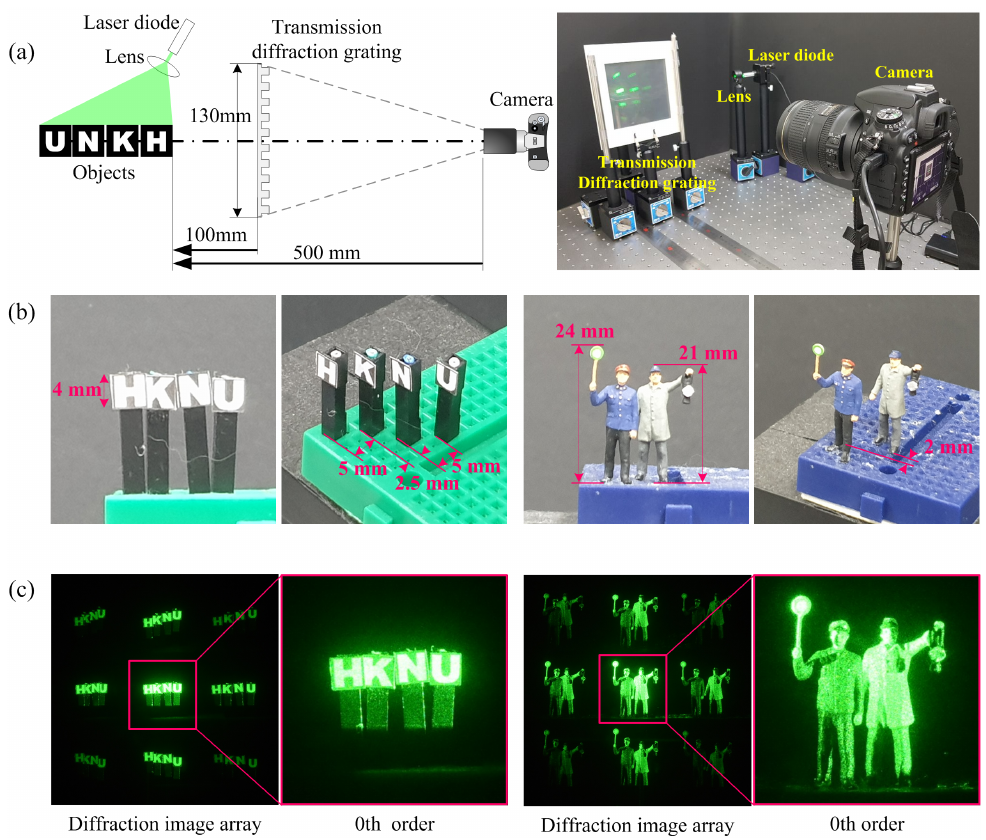
Figure 7. Optical experiment setup to acquire DIA. ( a ) Configuration of optical experiment and ( b ) The size of the objects used in the experiment and the distance between them and ( c ) diffraction image arrays (DIA) and the enlarged images of their 0th order diffraction images.